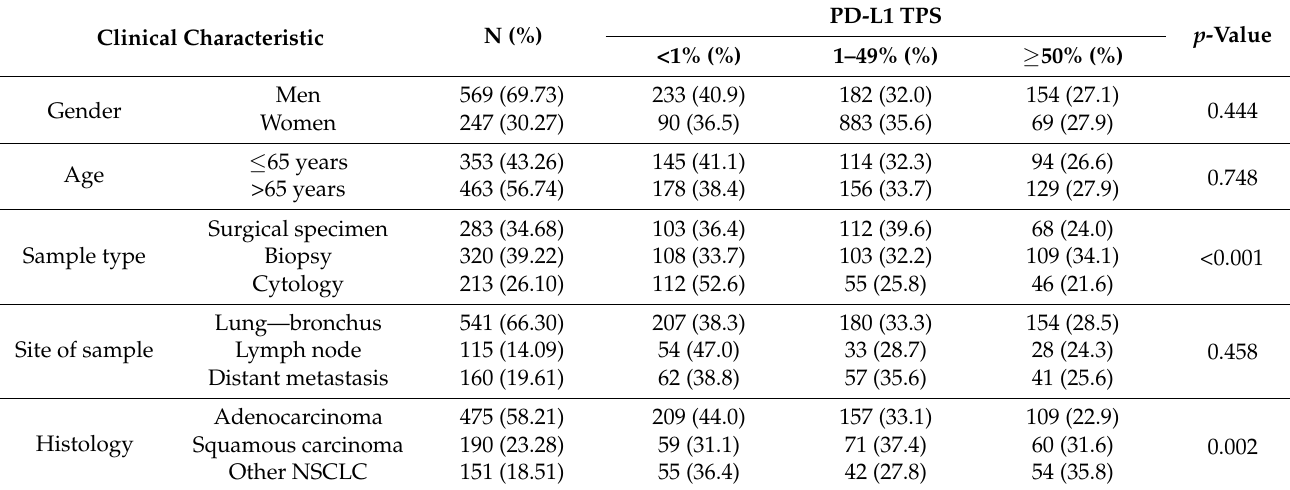
Table 1. Patient characteristics and group comparisons of PD-L1 result (N =